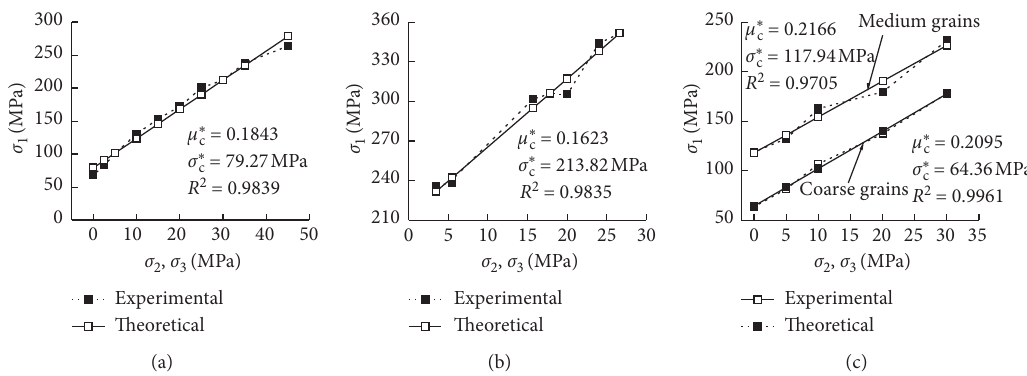
Figure 9: Conventional triaxial test data and theoretical results of (a) red sandstone [32], (b) Jinping marble [33], and (c) marble with medium and coarse grains [34].